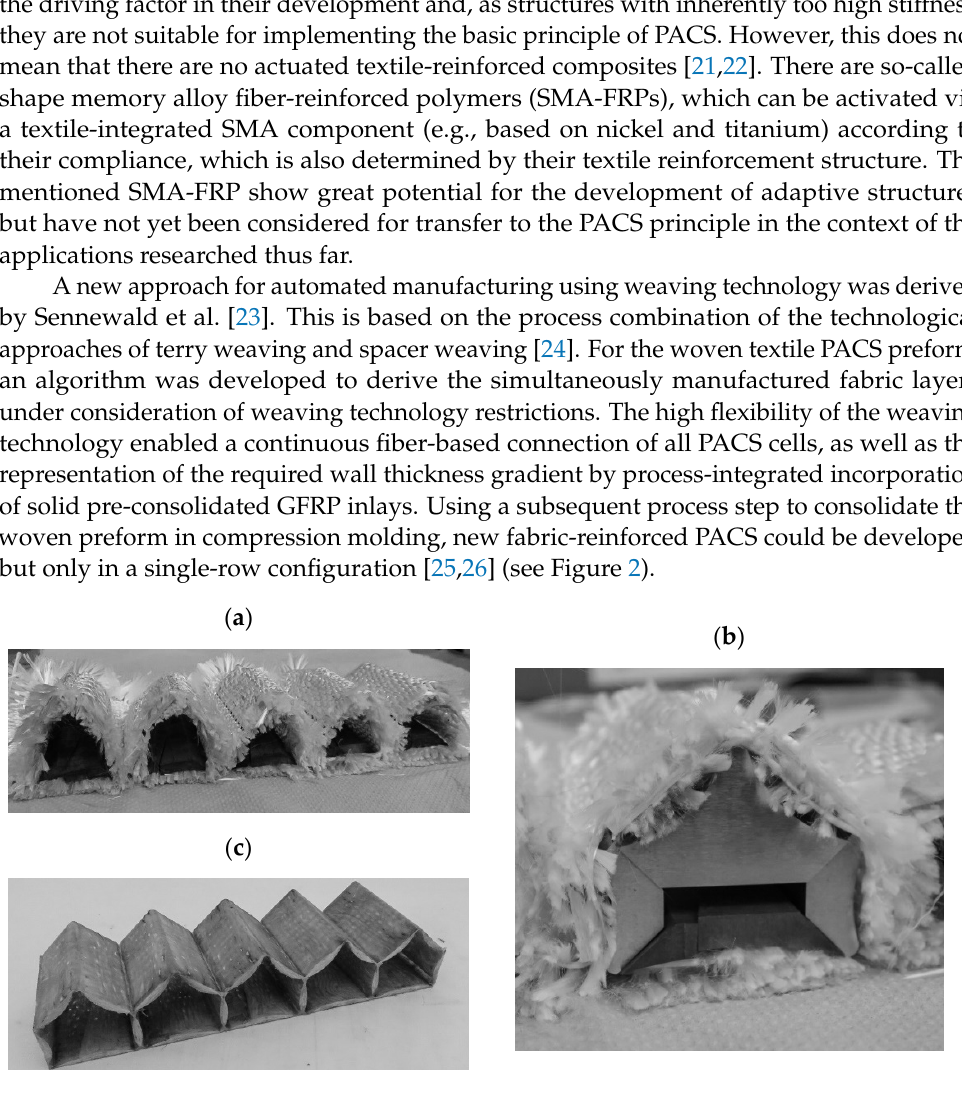
Figure 2. Textile reinforced single-row PACS: ( a ) woven fabric preform; ( b ) prepared preform with mold inlays before consolidation; ( c ) PACS composite.